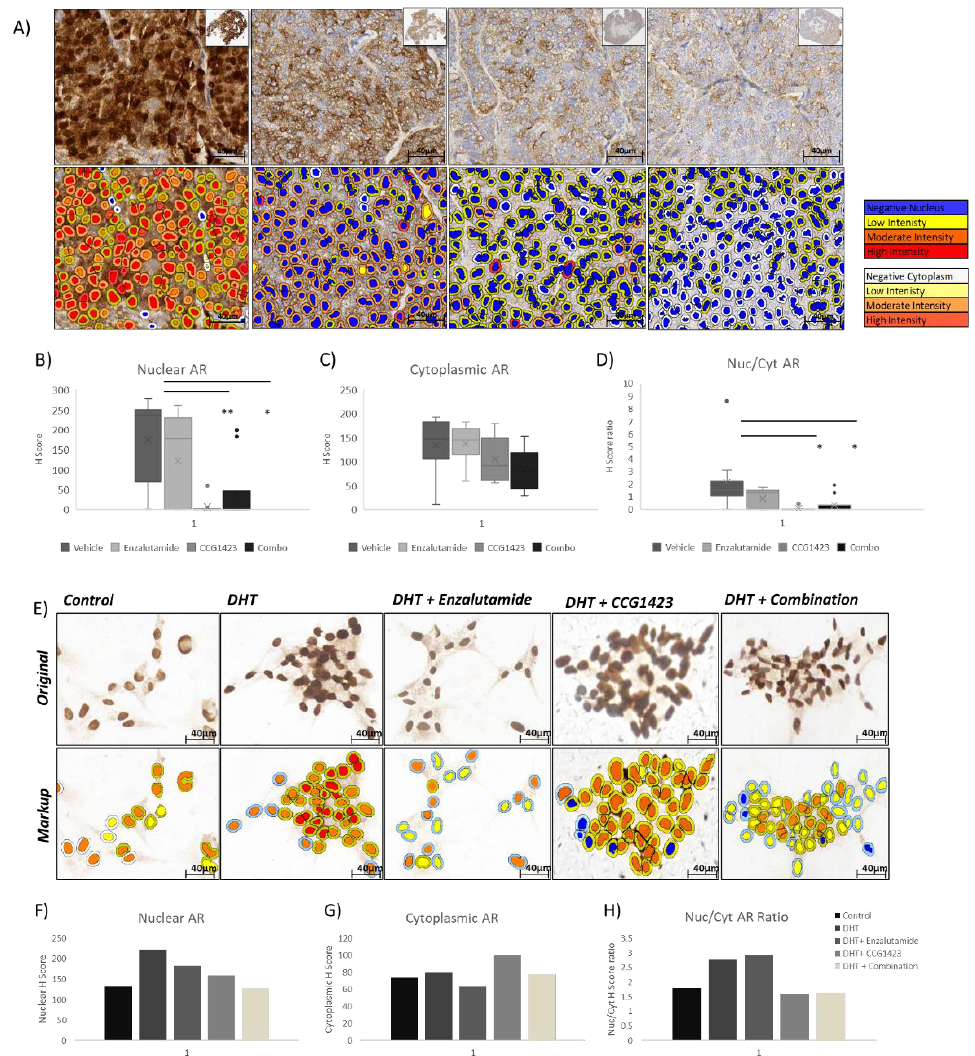
Figure 3. Immunohistochemistry (IHC) staining for androgen receptor (AR) was performed as described in the methods section. ( A ): Representative images of AR staining in the four treatments groups. Top panel shows original images (20 × magnification); bottom panel shows the markup images resulting from automatic quantification using Visopharm’s Oncotopix algorithms. ( B ): Nuclear AR protein expression (H score). ( C ): Cytoplasmic AR protein expression (H score). ( D ): Nuclear / cytoplasmic H score ratio. Average AR expression values for each treatment group were compared using one way ANOVA test for cytoplasmic AR staining and Welch’s ANOVA followed by post hoc Games–Howell test for nuclear AR and nuclear / cytoplasmic ratio. ** p < 0.01, * p < 0.05. ( E ): Immunocytochemistry (ICC) staining for AR in LNCaP Abl cells. Top panel shows original images (20 × magnification); bottom panel shows the markup images resulting from automatic quantification using Visopharm’s Oncotopix algorithms. ( F ): Nuclear AR protein expression (H score). ( G ): Cytoplasmic AR protein expression (H score). ( H ): Nuclear / cytoplasmic H score ratio. Images and quantification are representative of three independent experiments. DHT: dihydrotestosterone.